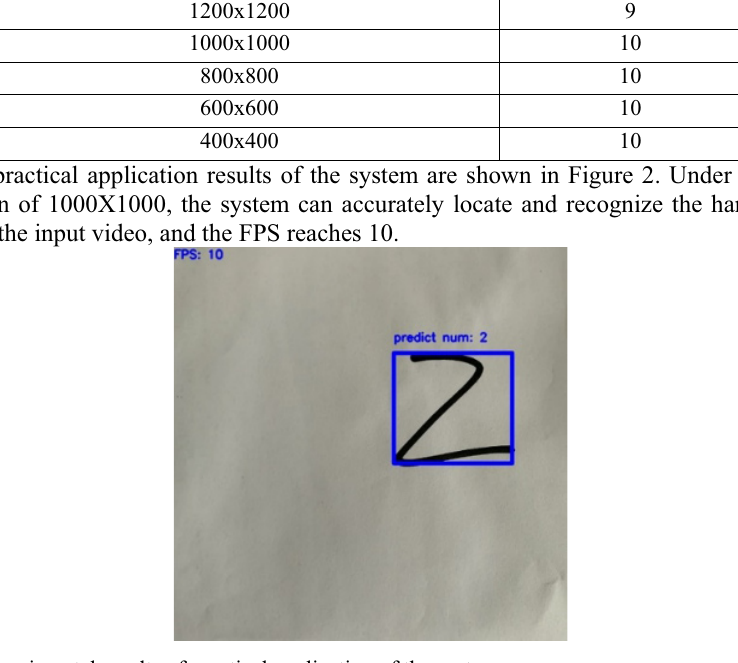
Fig. 2. Experimental results of practical application of the